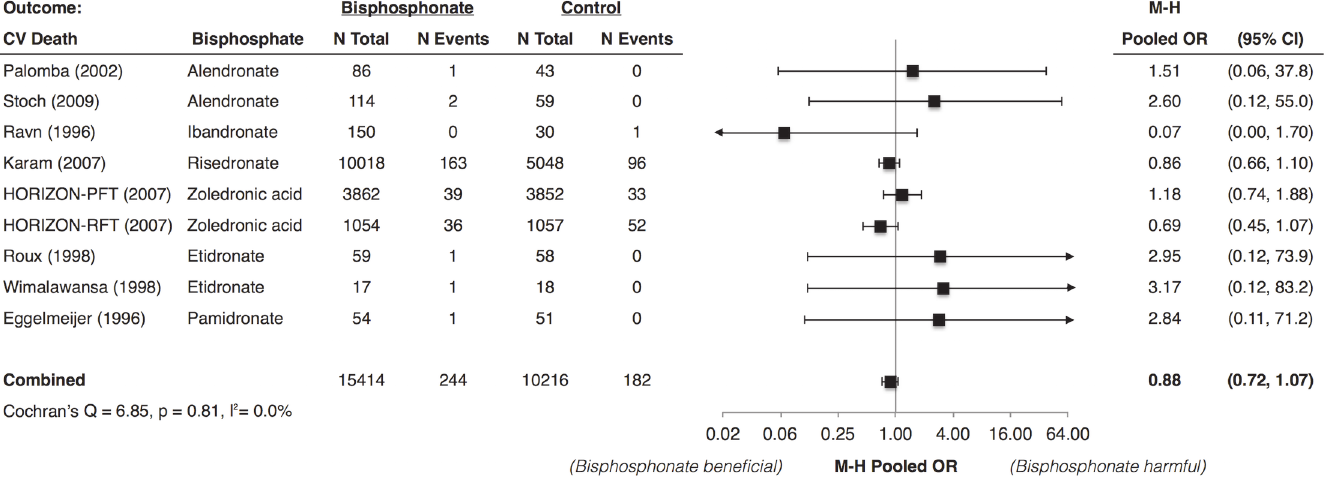
Fig 5. Meta-Analysis of Cardiovascular Mortality with Use of Bisphosphonates. * Abbreviations: CI, confidence interval; CV, cardiovascular; HORIZON-PFT, the Health Outcomes and Reduced Incidence with Zoledronic Acid Once Yearly Pivotal Fracture Trial; HORIZON-RFT, the Health Outcomes and Reduced Incidence with Zoledronic Acid Once Yearly Recurrent Fracture Trial; M-H, Mantel Haenszel; OR, odds ratio. * Karam (2007) et al. included data from 6 trials of risedronate. Individual study data were not available.